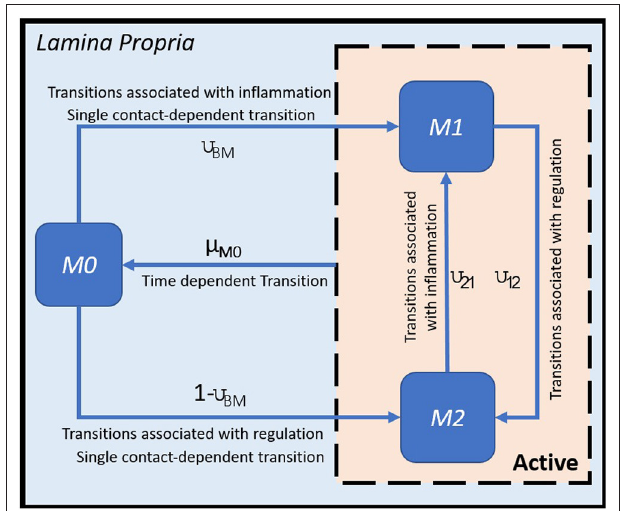
FIGURE 1 | State transition functions for macrophages (adapted from [49]).